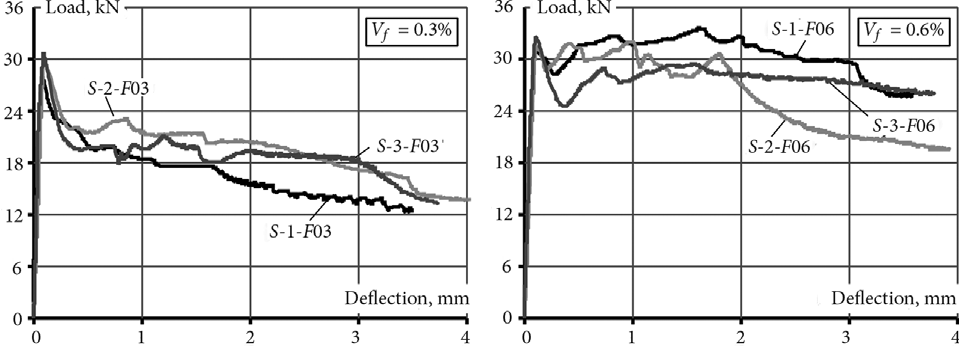
Fig. 5. Load-deflection diagrams of the beams subjected to four-point loading (DAfStb test)